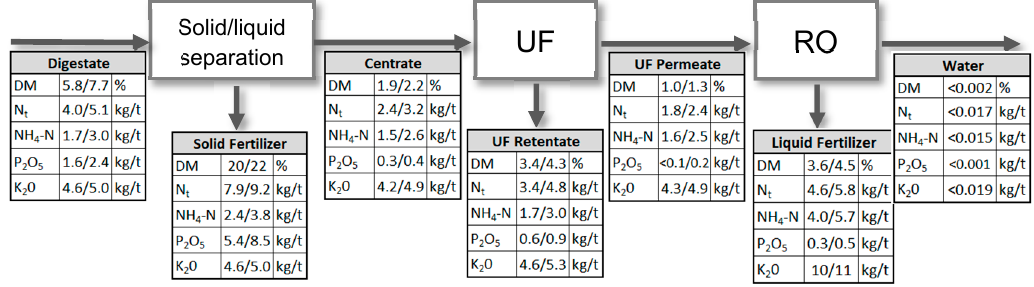
Figure 10. Mean dry matter and nutrient concentrations in process streams of BP I (first value) and BP II (second value).